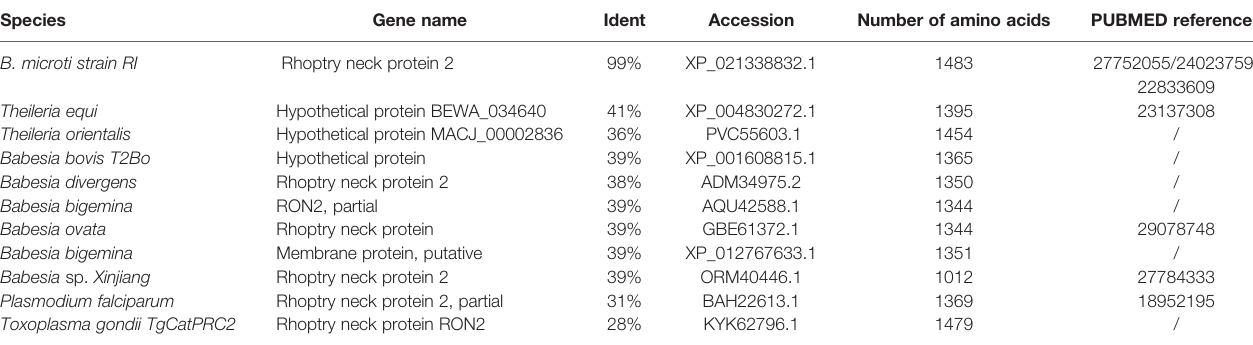
TABLE 2 | Sequence analysis of homologous proteins compared with the RON2s from NCBI.